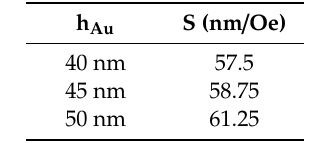
Figure 12. Influence of magnetic field intensity on the loss spectrum with di ff erent h Au from 40 nm to 50 nm, ( a ) h Au = 40 nm, ( b ) h Au = 45 nm, ( c ) h Au = 50 nm, and ( d ) the fitted results of resonant wavelength of y-polarized fiber core mode with di ff erent magnetic field intensity, where the red, blue, and black markers are the simulation results. Table 3. Comparison of the magnetic field sensitivity of the proposed PCF-SPR with di ff erent h Au from 40 nm to 50